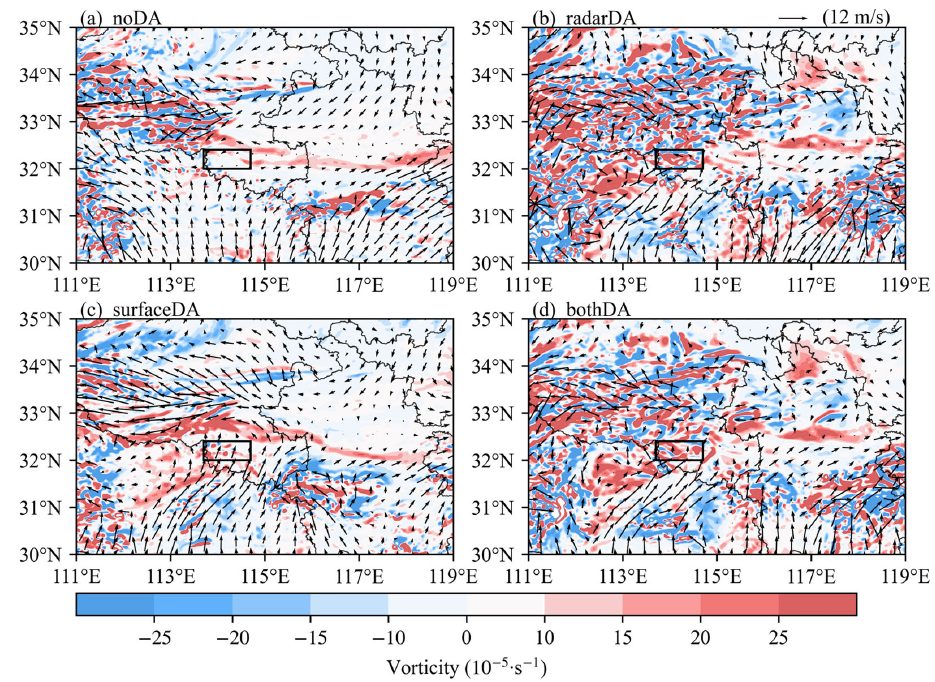
Figure 12. The horizontal distribution of 800 hPa wind fields (quiver, units: m/s) and divergence (shaded, units:10 − 5 ∙ s − 1 ) at 1530 UTC 11 July 2014 for ( a ) noDA, ( b ) radarDA, ( c ) surfaceDA and ( d ) bothDA experiments, the black box in the figure is the same as that in Figure 9.